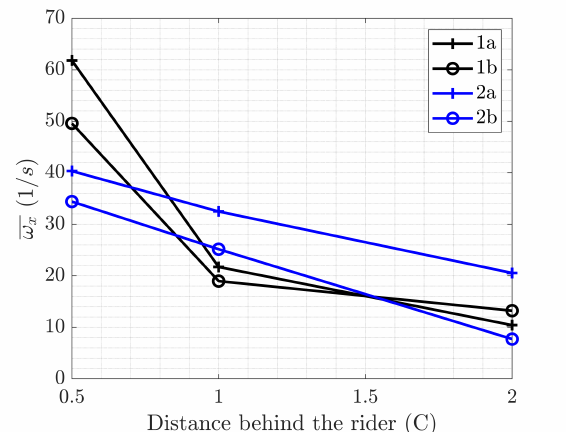
Figure 9. A quantitative comparison of the wake decay based on ω x at the vortex cores varying from 0.5 to 2 C behind the